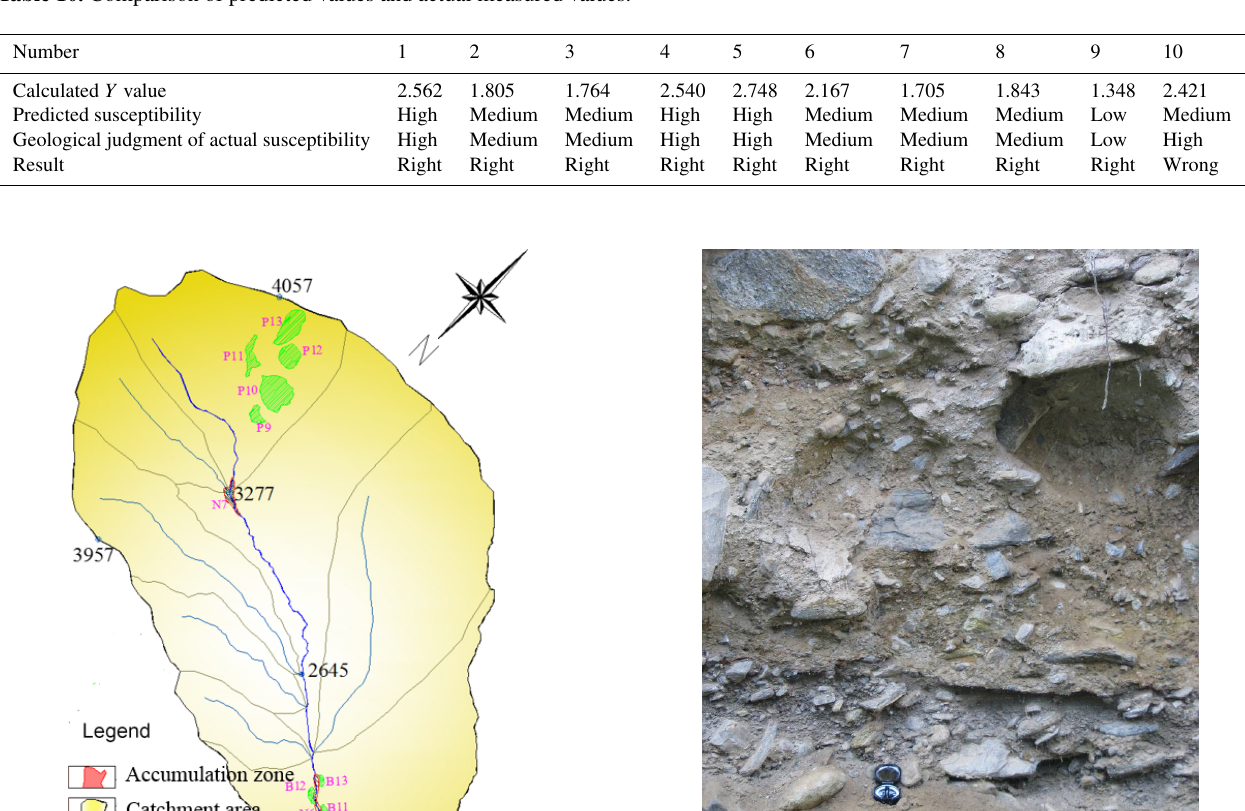
Table 10. Comparison of predicted values and actual measured values.